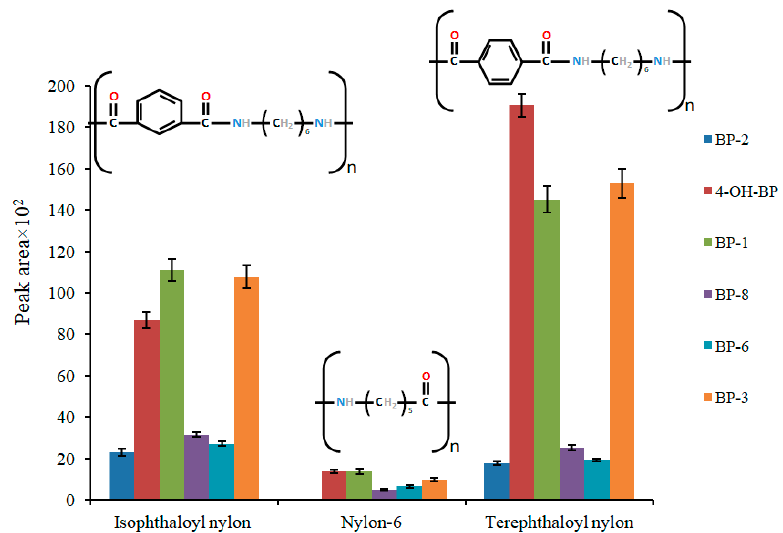
Figure 2. Figure 2. The effect of the polyamide type on the extraction of the target compounds. The chemical structure of the polyamides is also shown. Extraction conditions: Sample volume, 10 mL; sorbent